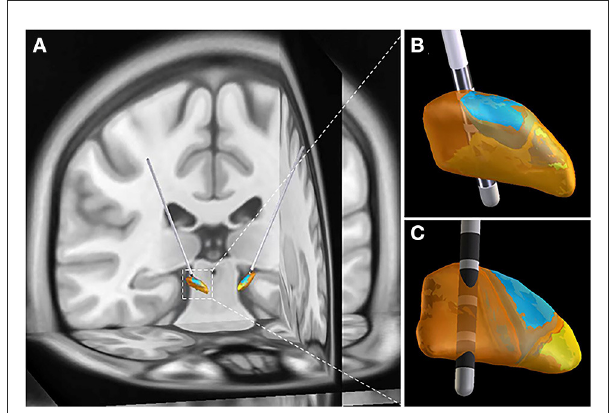
FIGURE3 Representative case with electrodes implanted into sensorimotor STN. (A) 3-D image reconstructed by preoperative MRI image and postoperative CT image. (B) Anterior view of STN. (C) Posterior view of STN. STN is partitioned into sensorimotor (orange), limbic (yellow) and associative (blue) subregions. The image reconstruction was performed by